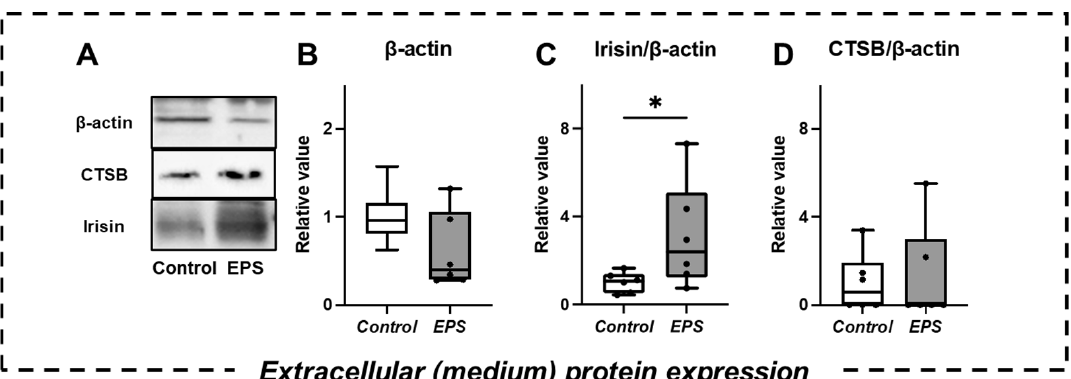
Figure 3. Comparison of extracellular protein expression in culture medium ( A ). Western blot analyses with anti- β -actin ( B ), irisin ( C ), and CTSB ( D ) were performed ( n = 6). Irisin and CTSB expression levels were normalized to the β -actin level. Proteins are expressed relative to the value of the control protein levels (relative value). Values are presented as the median (horizontal line in the box), range between the 25th and 75th quartiles (box), and maximum and minimum values (whisker). At least two independent experiments were performed. * Significant difference between groups ( p < 0.05).